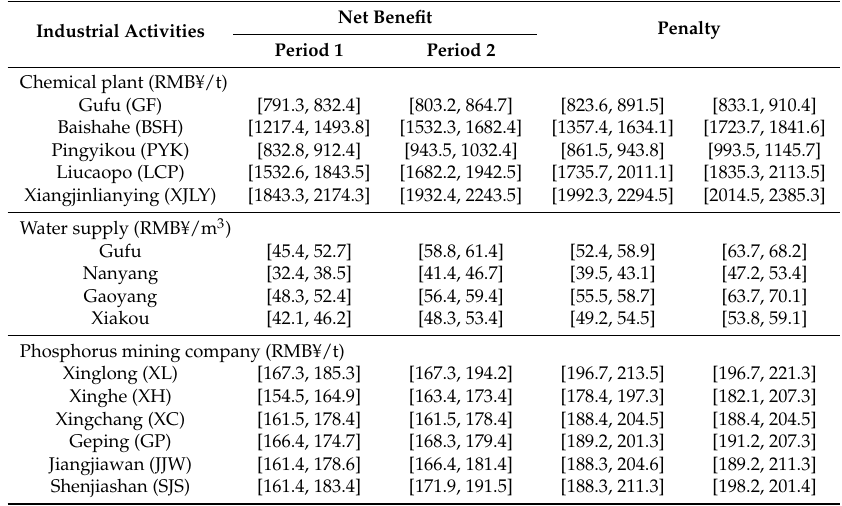
Table 1. Net benefits and penalties from industrial activities.